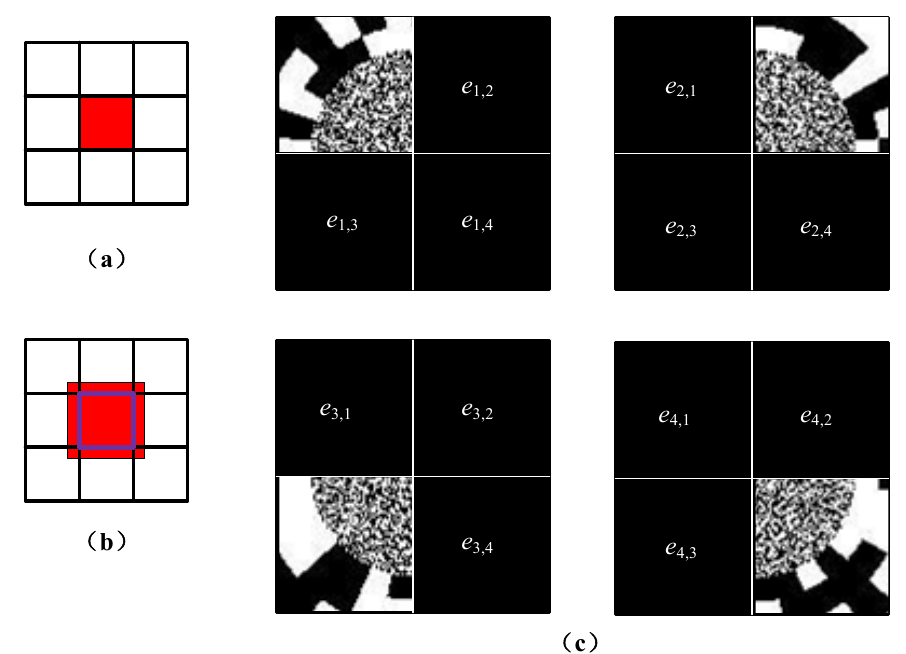
Figure 11. System calibration. ( a ) Ideal detector block; ( b ) Real detector block; ( c ) System calibration for 2 × 2 blocks.